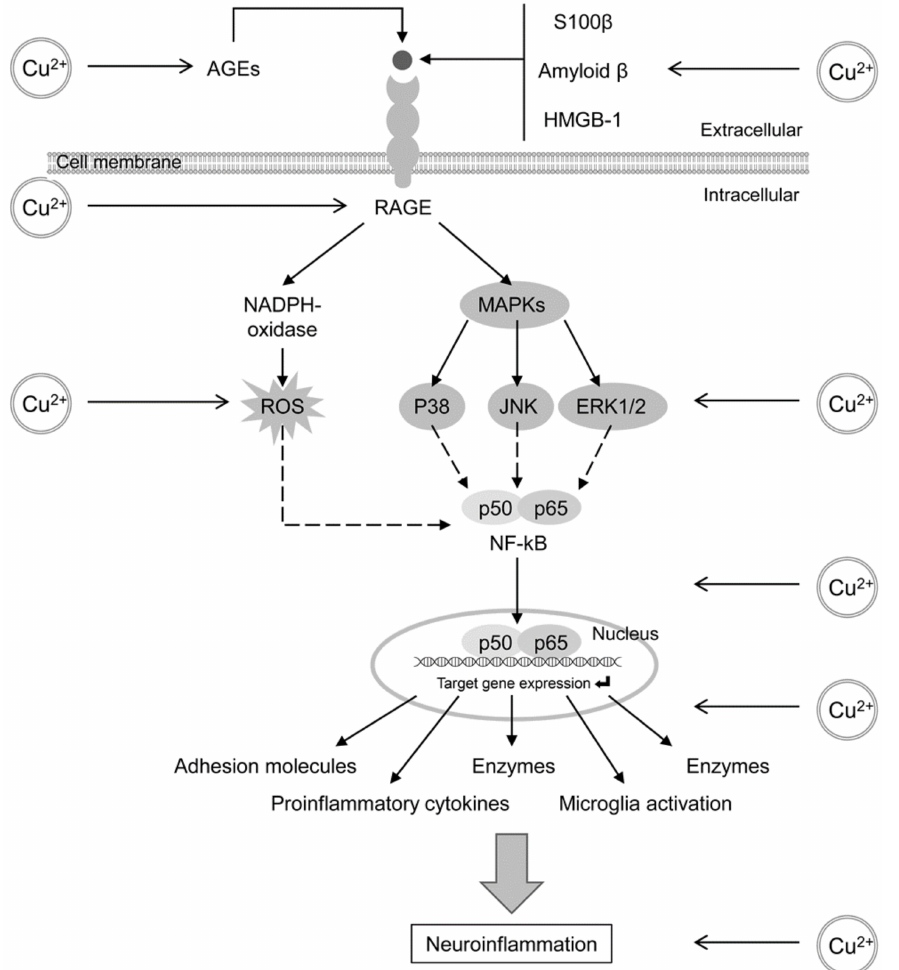
Figure 2. The role of AGE/RAGE signaling in neuroinflammation and its potential role as a mediator of neuroinflammatory effects of copper (Cu) and other metals. Binding of AGEs and other substrates (including A β , S100 protein and high-mobility group protein B1) to RAGE results in its activation with subsequent up-regulation of NADPH-oxidase and ROS generation, as well as MAPK (including p38, ERK1/2 and JNK) activation, which together cause NF-kB activation. The latter results in